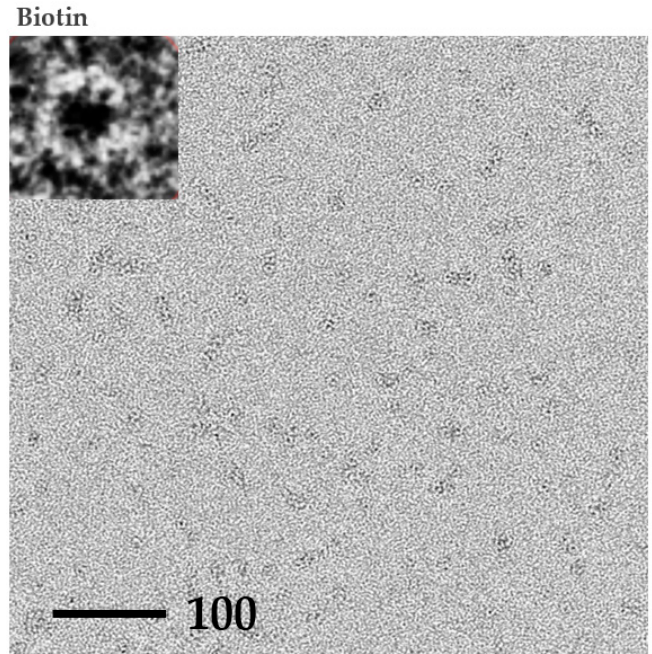
Figure 6. TEM images of dissolved P61C hoefavidin crystals. TEM images of negatively stained P61C hoefavidin dissolved crystals in an apo or biotin complex form, as indicated. Insets show one typical enlarged particle of each sample demonstrating the cylindrical assembly. Many particles could be detected in each sample, having the size and shape of the expected octamer. There is no apparent difference between the apo and biotin complex samples, indicating the stability of the octamer.